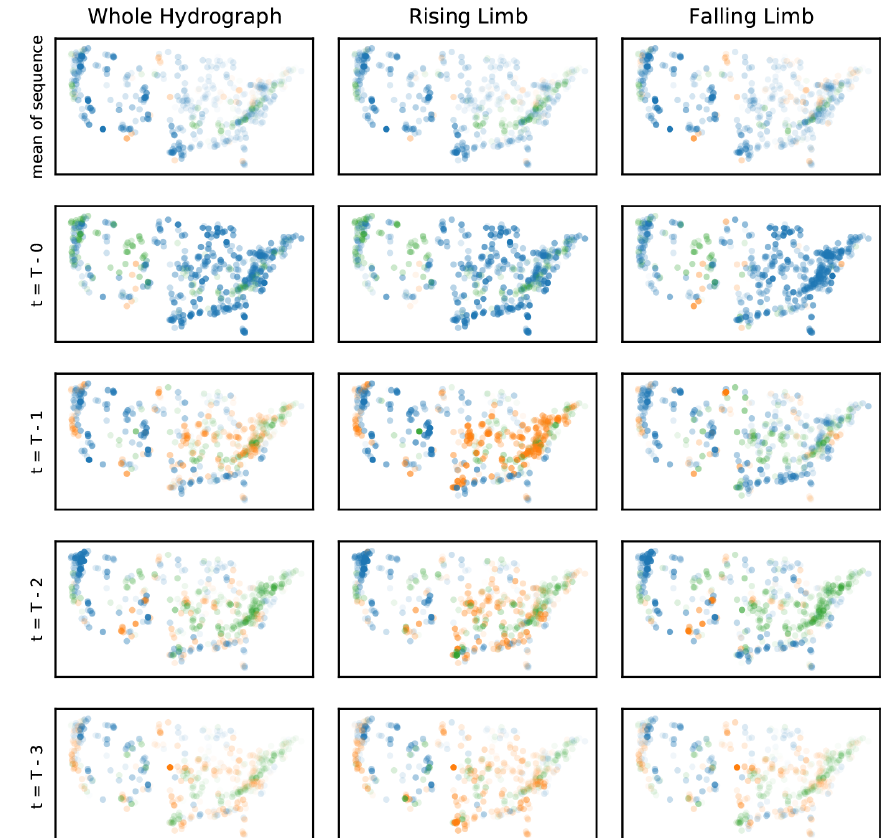
Figure 9. Spatial distribution of the highest-ranked precipitation products at specific lags (different rows) over the whole hydrograph (left- hand column), and the rising and falling limbs of the hydrograph (center and right-hand columns, respectively), where blue circles denote Daymet, orange circles denote Maurer and green circles denote NLDAS. The takeaway from this figure is that the multi-forcing LSTM learns to combine the different products in different ways for different memory timescales in different basins and under different hydrological conditions. The alpha value (opacity) of each dot is a relative measure of the fraction of the total integrated gradients of all three precipitation products due to the highest-contributing